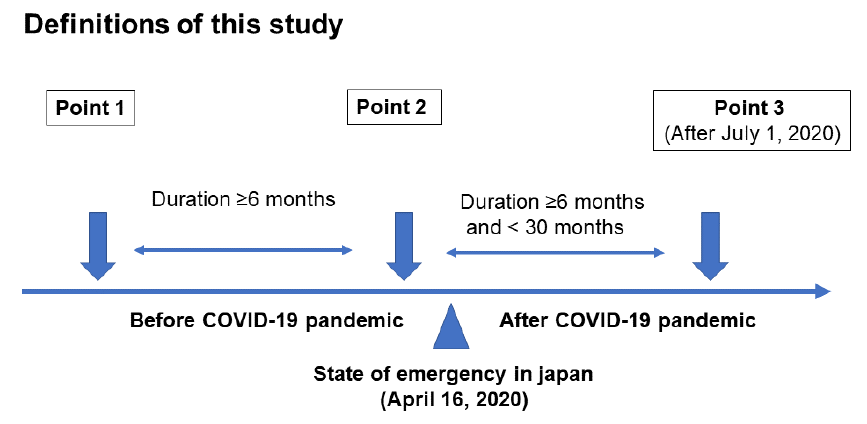
Figure 1. Definitions of this Figure 1 . Definitions of this study.